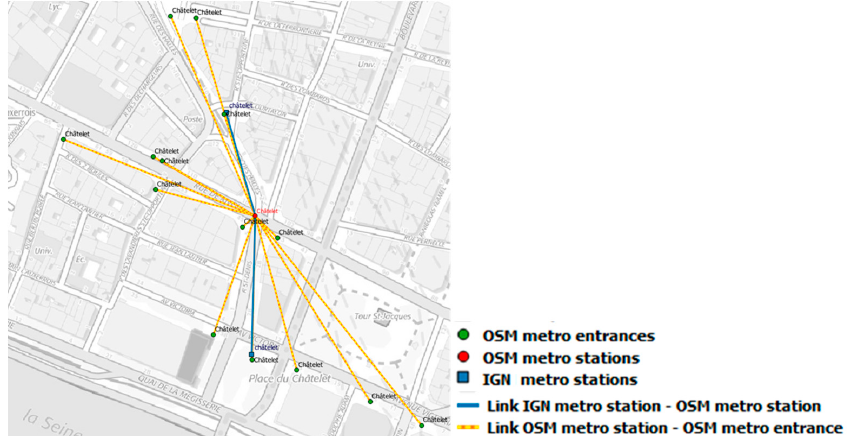
Figure 11. Data matching results for Châtelet subway station (©OpenStreetMap contributors, ©BDTOPO).